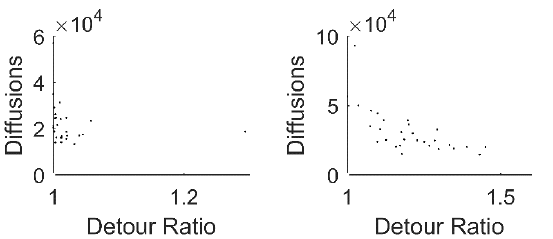
Figure 2. Diffusion - Detour Ratio diagram for experimented variation of ACO for some random start- destination points.